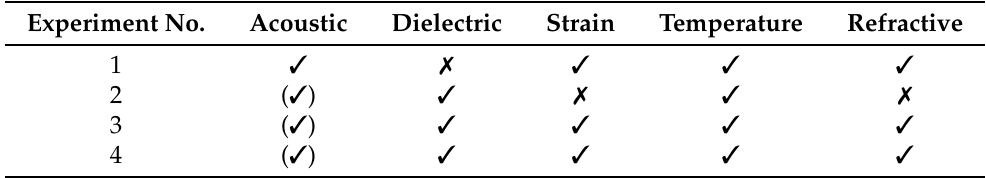
Table 4. Overview over the different experiments.